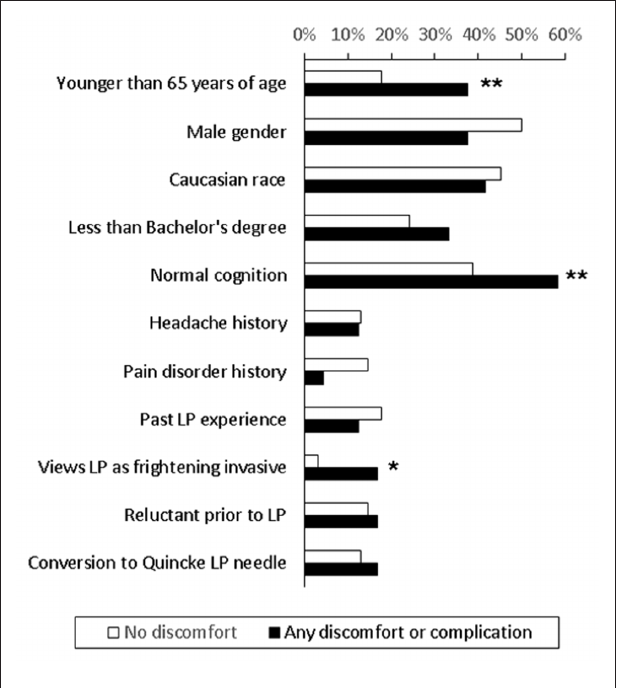
FIGURE 2 | Comparison of subjects who did ( n = 24) and did not ( n = 62) report discomfort or complications. ∗ More common among those who reported discomfort or complication, p < 0.05. ∗∗ More common among those who reported discomfort or complication, 0.10 > p ≥